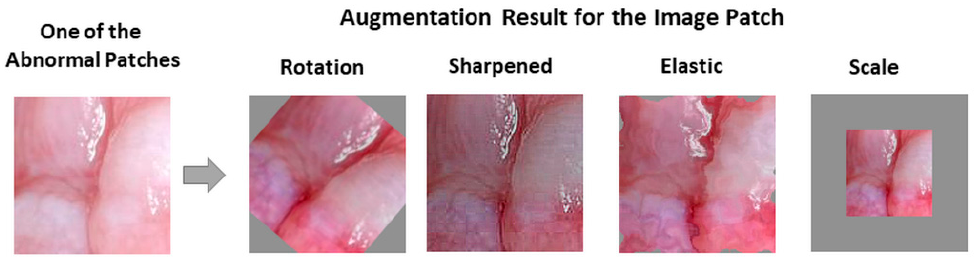
Figure 5. Examples of patch augmentation after rotation, sharpened, elastic, and scale.